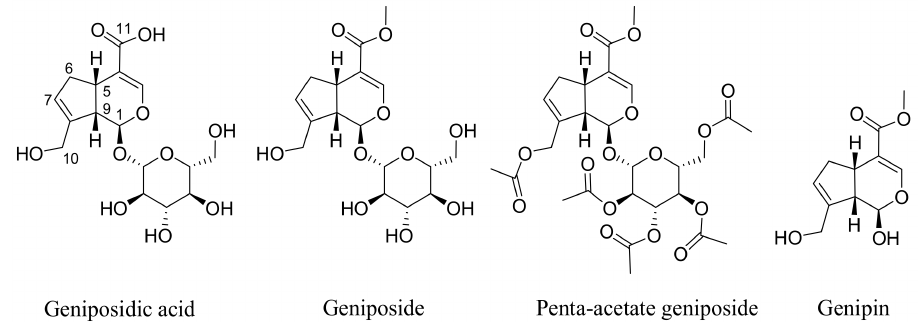
Figure 1. Structures of geniposide and its analogues. Geniposide is a natural analogue or methyl ester of geniposidic acid. Genipin is the aglycone of geniposide which is also present in plants, while penta-acetyl geniposide is a synthetic derivative widely employed in anticancer activity